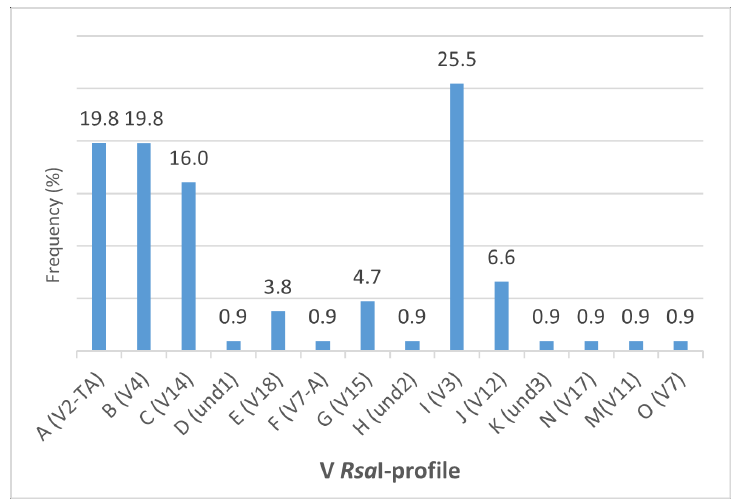
Figure 4. Distribution of the Rsa I-V vmp1 profiles determined by restriction fragment length poly- morphism (RFLP) analysis of vmp1 amplicons in the 111 samples amplified.